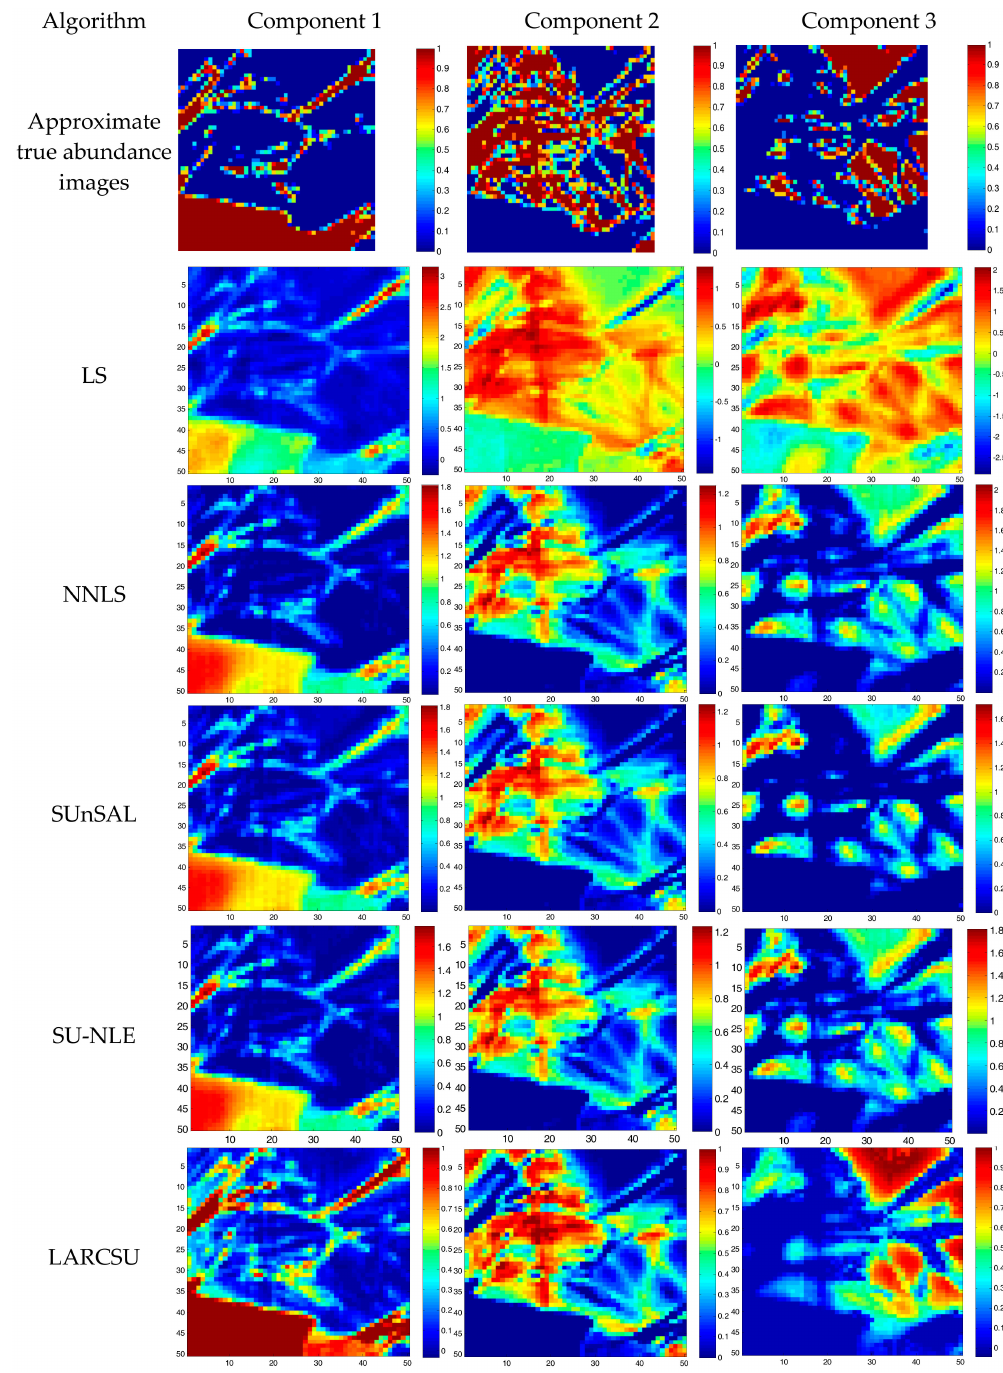
Figure 9. Estimated abundances of different components for